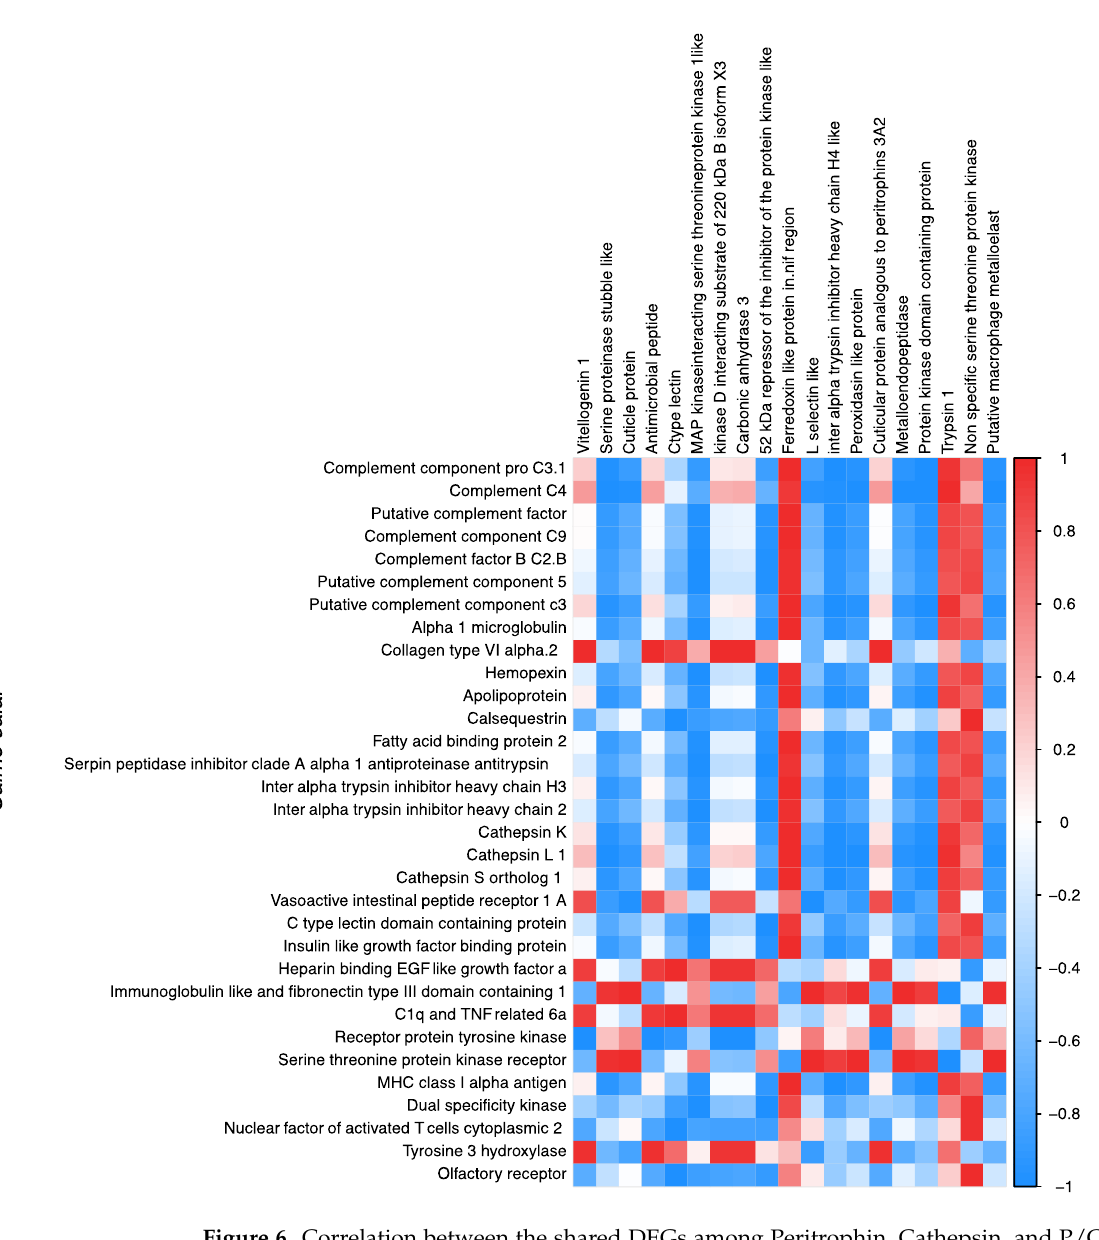
Figure 6. Correlation between the shared DEGs among Peritrophin, Cathepsin, and P/C vaccine prototypes. The genes of S. salar and C. rogercresseyi are shown on the Y and X axes, respectively. The matrix shows the correlation coefficients between the TPM values of the shared DEGs of S. salar and C. rogercresseyi . Red and blue colors indicate significant correlations (significant positive or negative correlations, respectively).